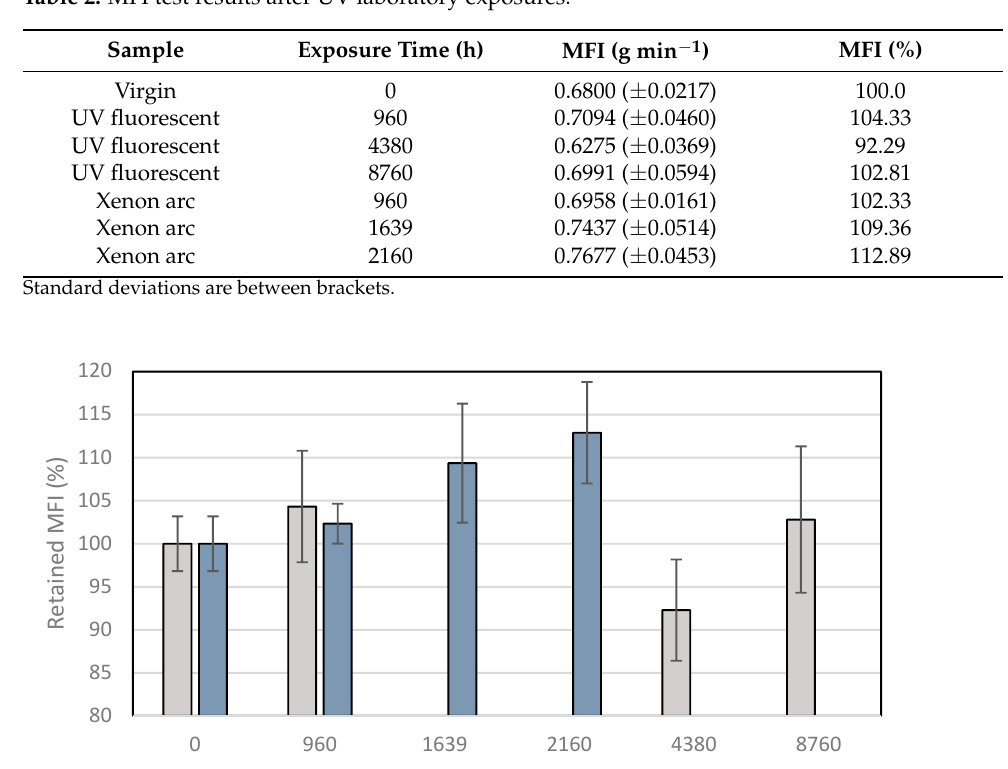
Table 2. MFI test results after UV laboratory exposures.